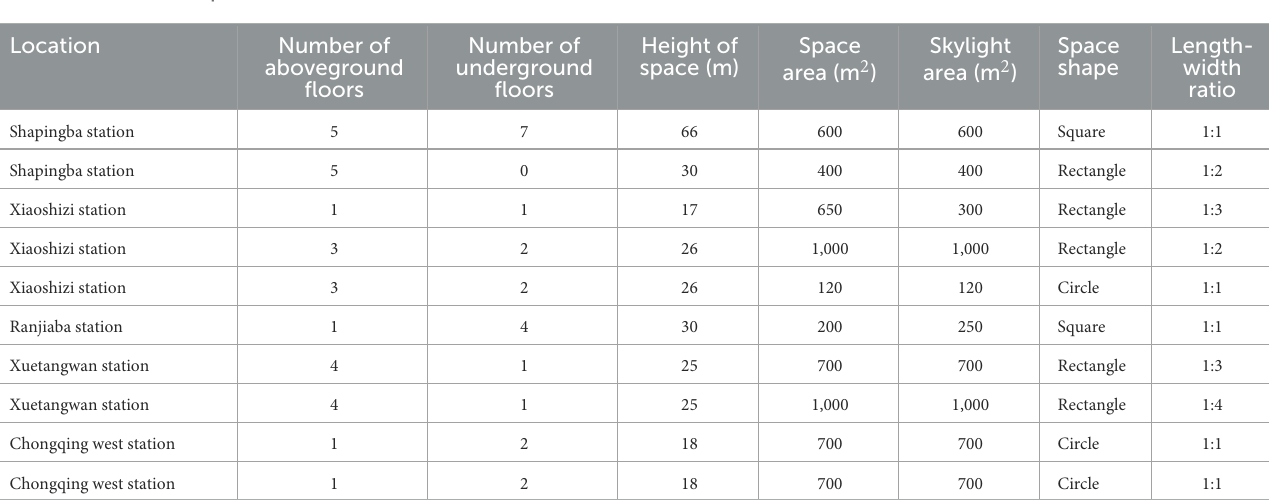
Height of space (m)